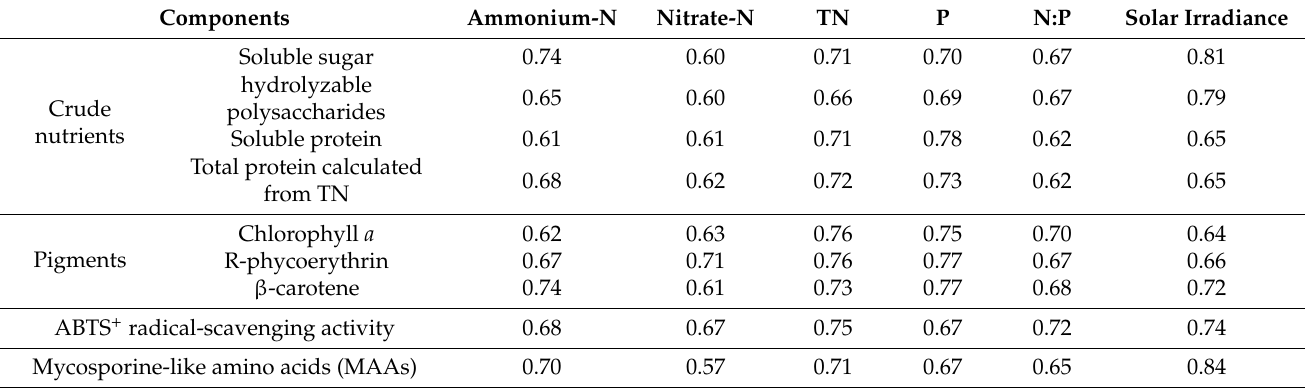
Table 2. Gray correlation coefficients between the contents of crude nutrients, pigments, MAAs, and ABTS + radical-scavenging activity in N. yezoensis and related environmental factors.